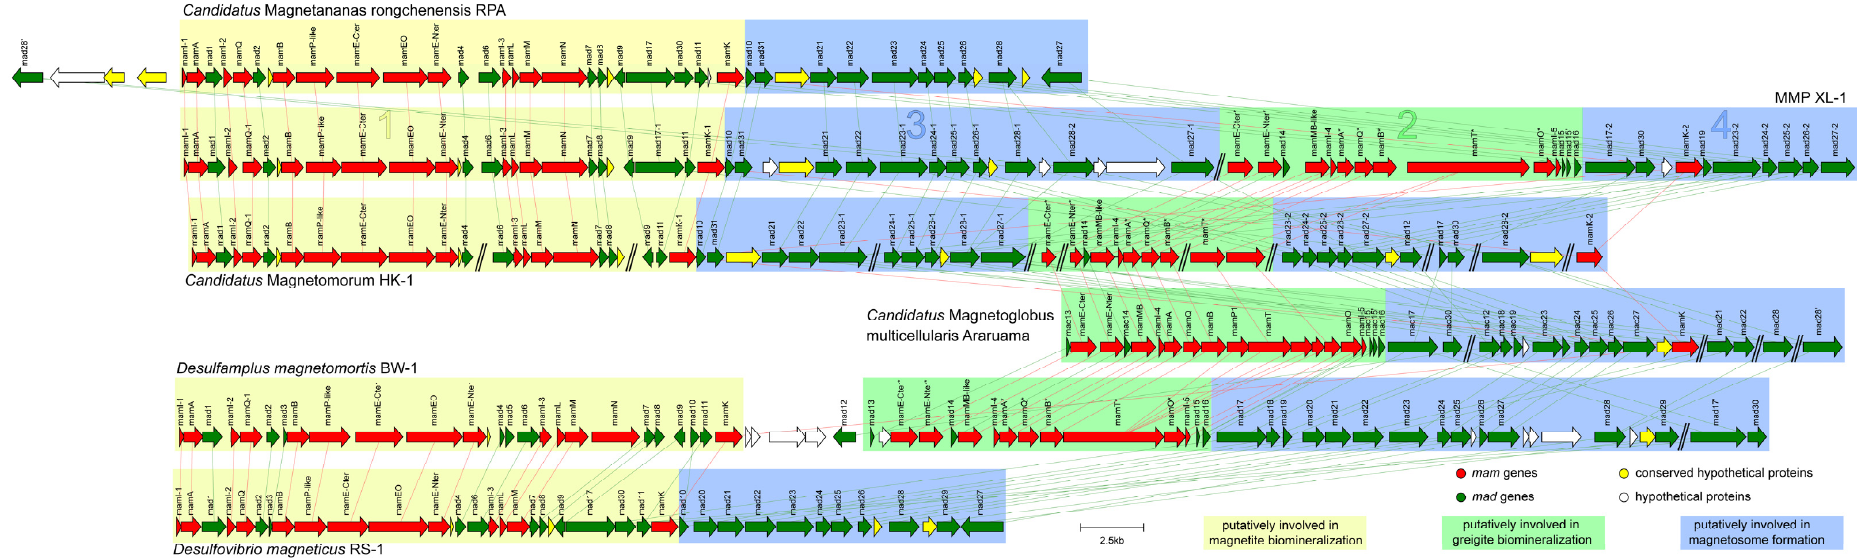
Figure 5. Comparison of MGCs from MMP XL-1 and other previously reported genomes, including Ca. Magnetananas rongchenensis RPA, Ca. Magnetomorum HK-1, Ca. Magnetoglobus multicellularis Araruama, Desulfamplus magnetomortis BW-1, and Desulfovibrio magneticus RS-1. The bars between clusters indicate homologous genes. The magnetosome genes putatively involved in magnetite biomineralization are enclosed by yellow, those putatively involved in greigite biomineralization are enclosed by green, and those putatively involved in magnetosome formation are enclosed by blue.